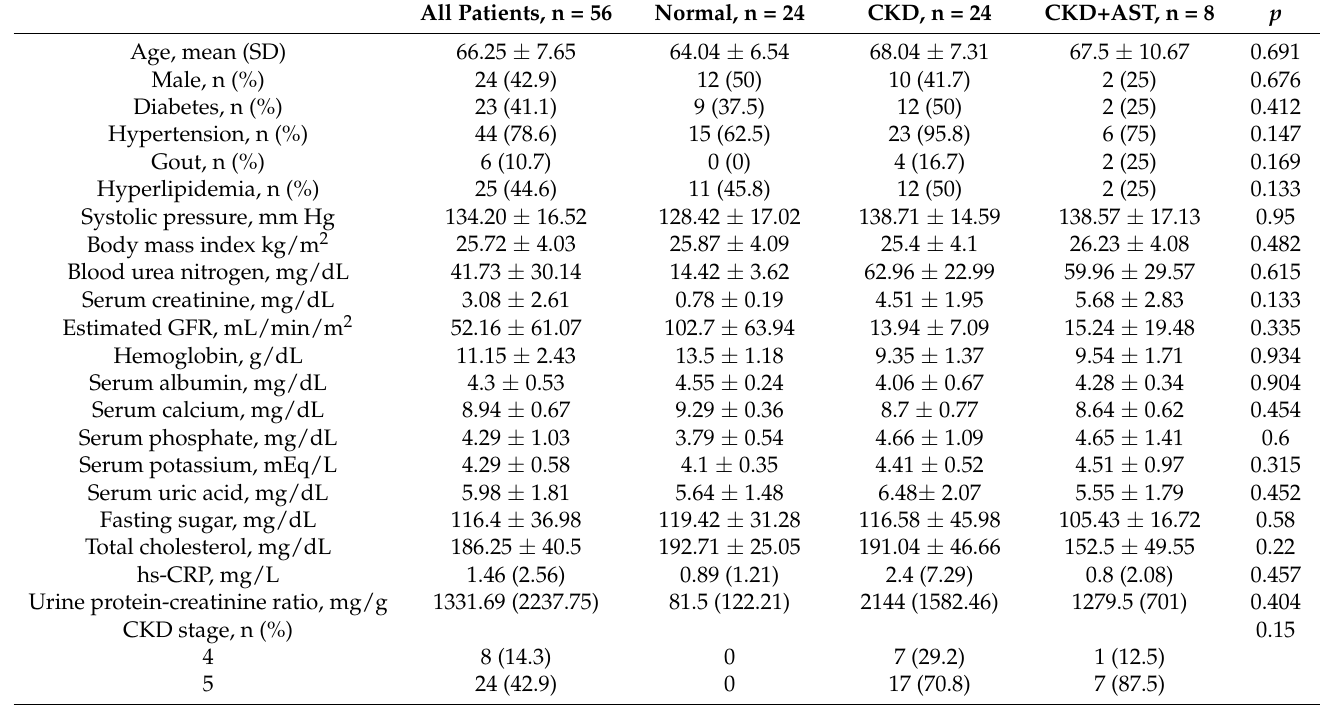
Table 1. Baseline characteristics of study population (n =